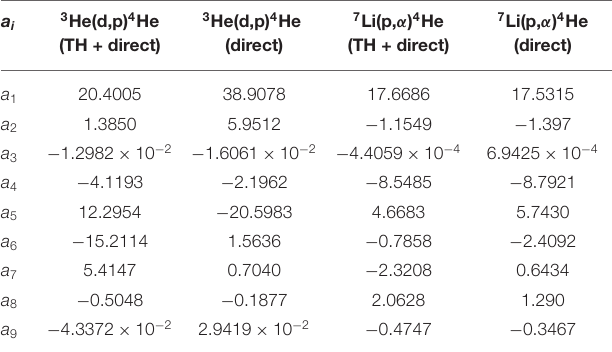
TABLE 4 | Parameters of the reaction rates of Equation (7) for 2 H(d,p) 3 H and 2 H(d,n) 3 He evaluated from the S-factors from TH + direct measurements and from direct measurements.